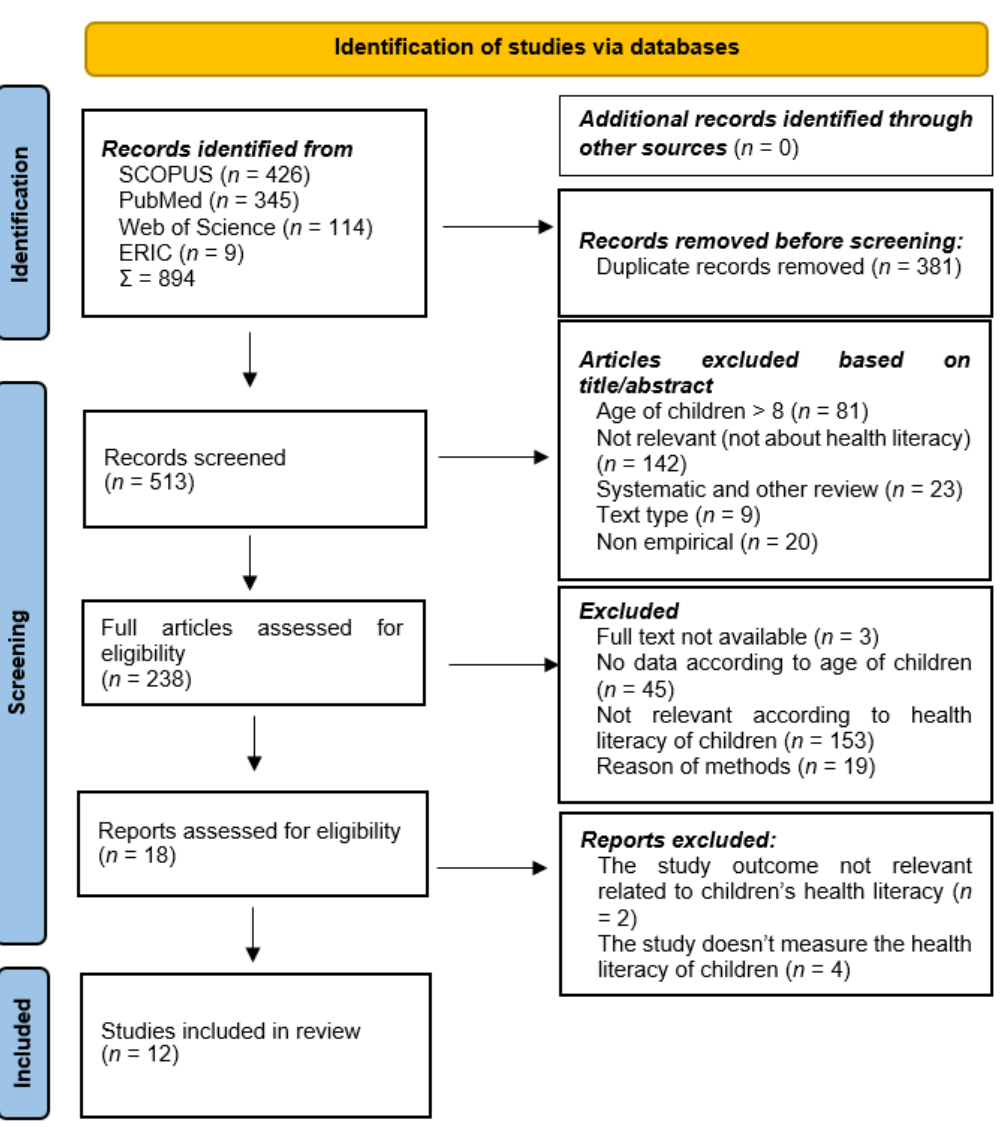
Figure 1. Flow chart of the searching process according to the PRISMA protocol .